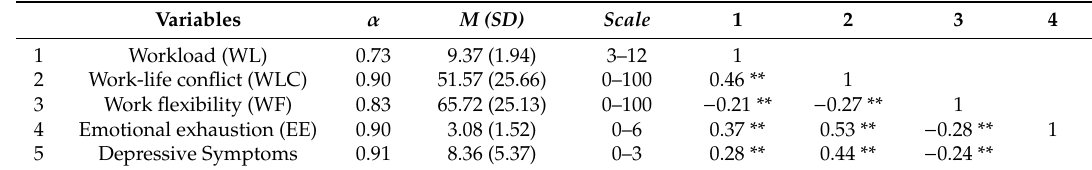
Table 2. Means, standard deviations, internal consistencies, and intercorrelations of model